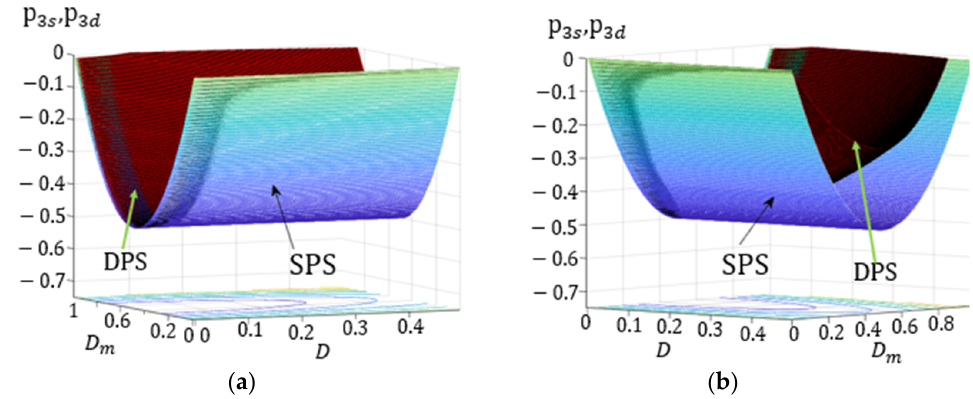
Figure 9. Unified powers at port 3 for both SPS and DPS control schemes ( a ) front and ( b ) rear view.